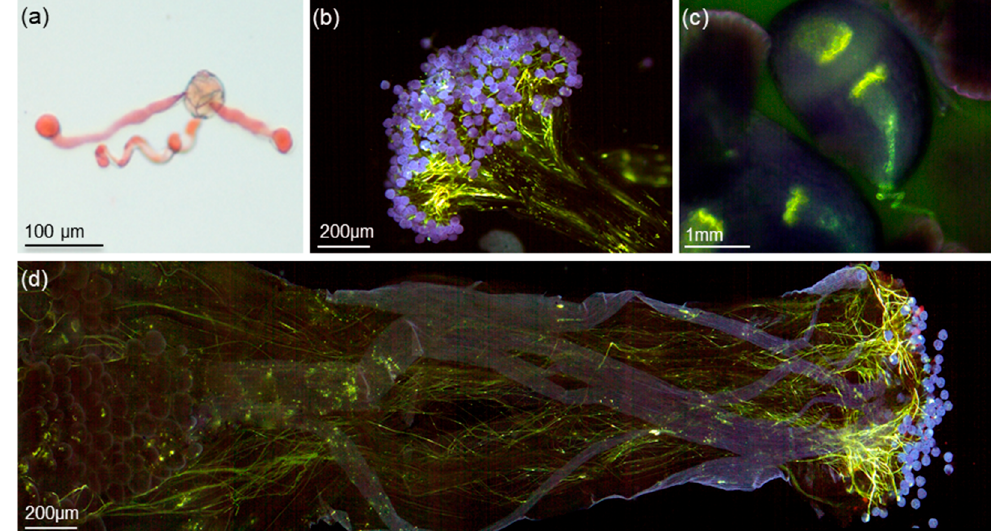
Figure 5. Strawberry tree pollen germination: ( a ) germinated pollen tetrad stained with aceto-car- mine; ( b ) germination of pollen grains on stigma; ( c ) pollen tube entering the ovule micropyle; ( d ) pollen germination on the stigma, and pollen tube growth along the pistil.